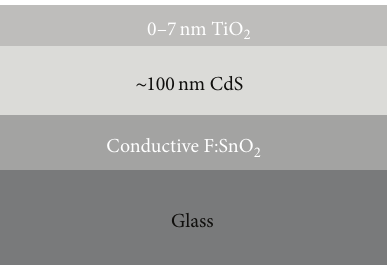
Figure2:SamplestructureoftheCdSphotoanodescoatedwiththin TiO 2